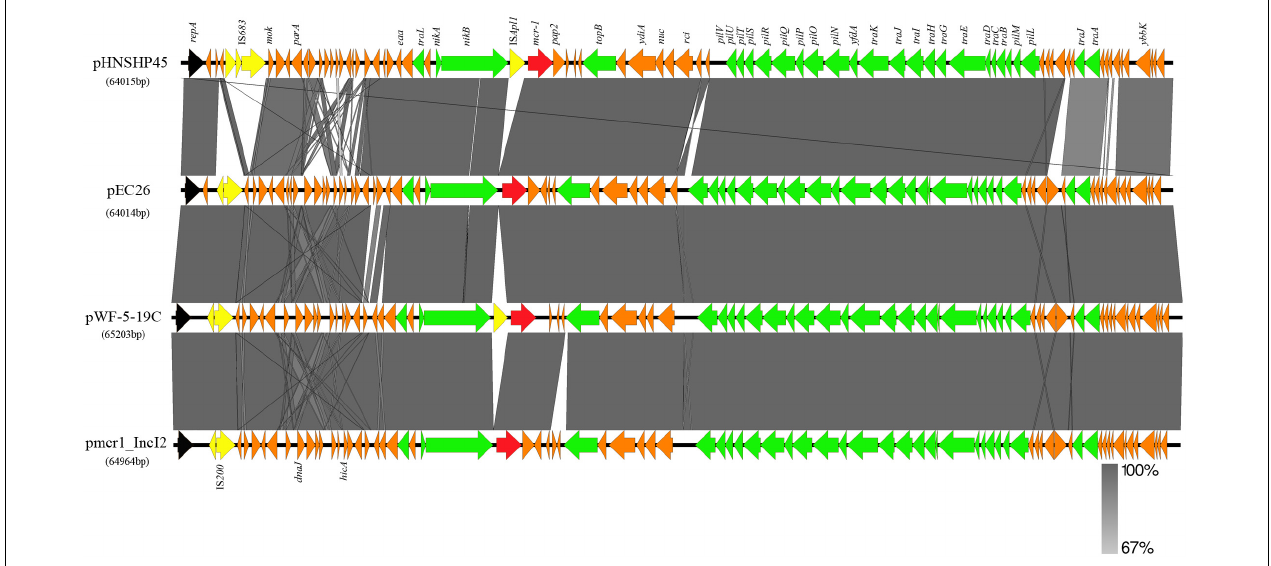
FIGURE 1 | Linear comparisons of complete sequences of the IncI2-type plasmids pHNSHP45 (accession no. KP347127), pmcr1_IncI2 (KU761326), pWF-5-19C (KX505142), and pEC26 (MG946761). Colored arrows represent open reading frames, with black, yellow, green, red, and orange arrows representing replication genes, mobile elements, plasmid transfer genes, the mcr-1 gene, and plasmid backbone genes, respectively. Gray shading denotes regions of shared homology amongst the different plasmids.